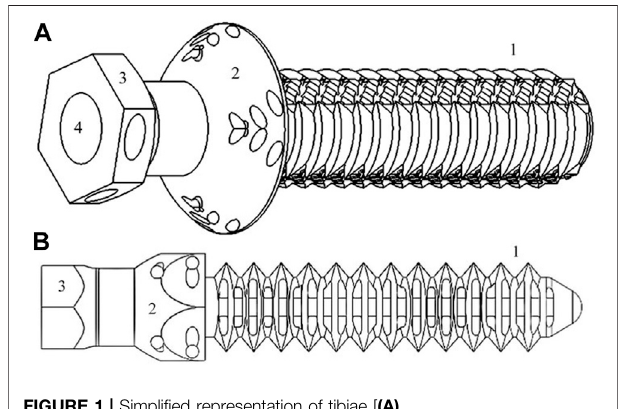
FIGURE 1 | Simpli fi ed representation of tibiae [ (A) , 16.54*50.21*14.72 mm 3 ] and radii [ (B) , 11.25*50.23*10.01 mm 3 ] PEEK plug of endoprosthesis designed in SolidWorks: (C) stem-section, (D) “ umbrella, ” (E) base, and (F) inner cavity where surgical metal threaded rod is